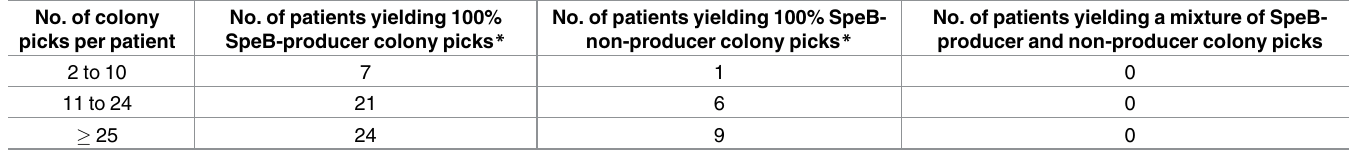
Table 3. Phenotype homogeneity among single colony picks from oropharyngeal swabs taken from pediatric patients with pharyngitis. No. of colony picks per